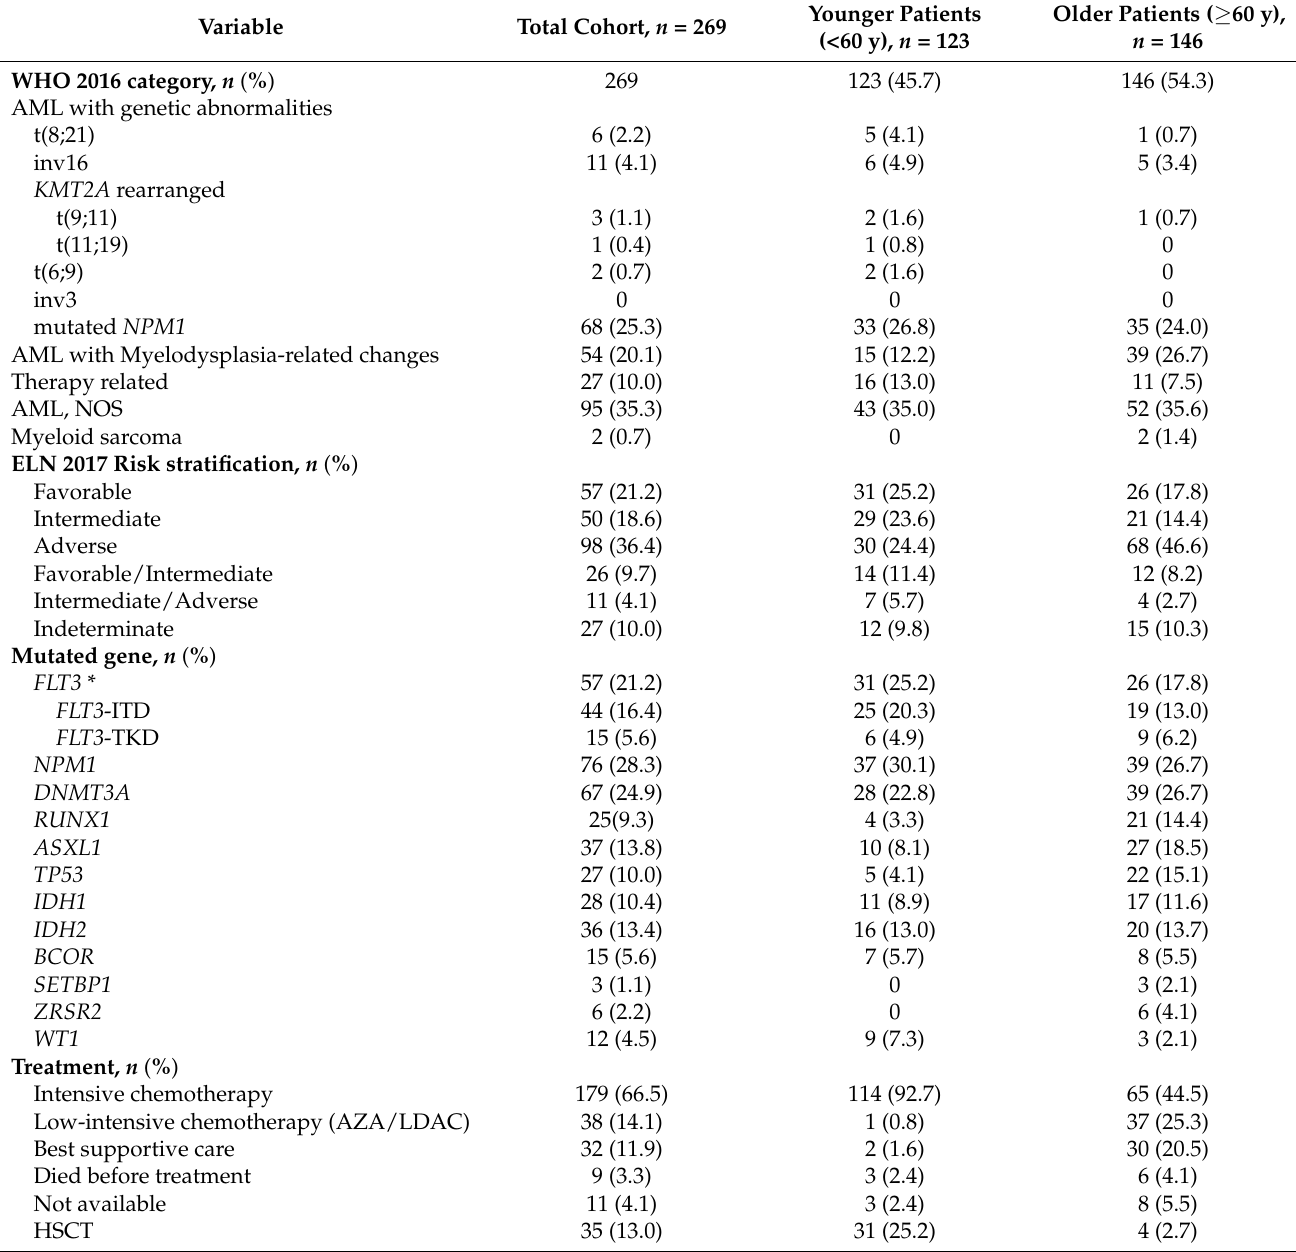
Table 2. WHO category, molecular characteristics, and type of treatment of the study